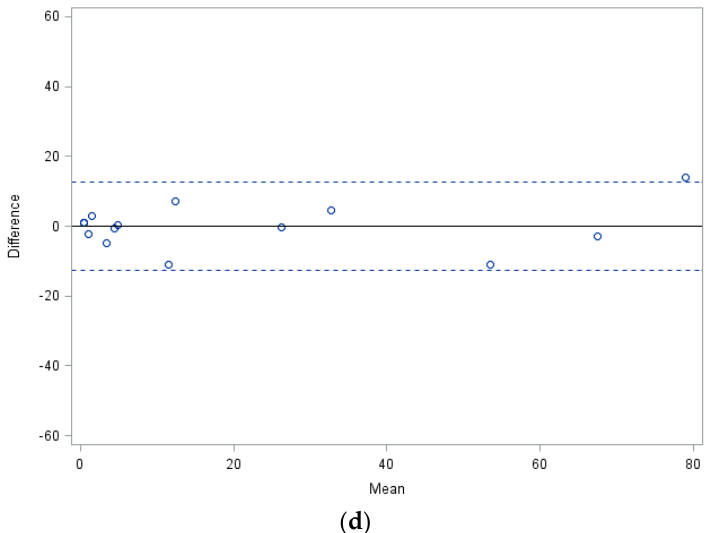
Figure 1. Comparison of quantitative mutant subclone assessment by different methods. The Bland-Altmann plots displayed show the distribution of mean ∆ values ( ∆ M ) with the respective 95% confidence intervals (dashed lines) for the pairwise comparison of ( a ) LD-PCR versus pyrosequencing- ∆ 1; ( b ) LD-PCR versus NGS (MiSeq platform)- ∆ 2; ( c ) pyrosequencing versus NGS (MiSeq platform)- ∆ 3; ( d ) LD-PCR versus NGS (GS Junior platform). The number of data points varies between different pairwise comparative analyses because a proportion of cDNA specimens were not amenable to testing by all technical approaches. In some instances, individual points represent identical results of different measurements.